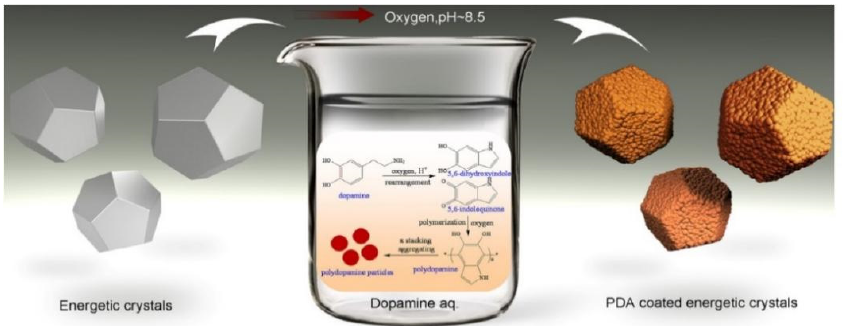
Figure 5. Possible deposition process of PDA on HMX crystal. Reproduced with permission from [64], copyright 2017,